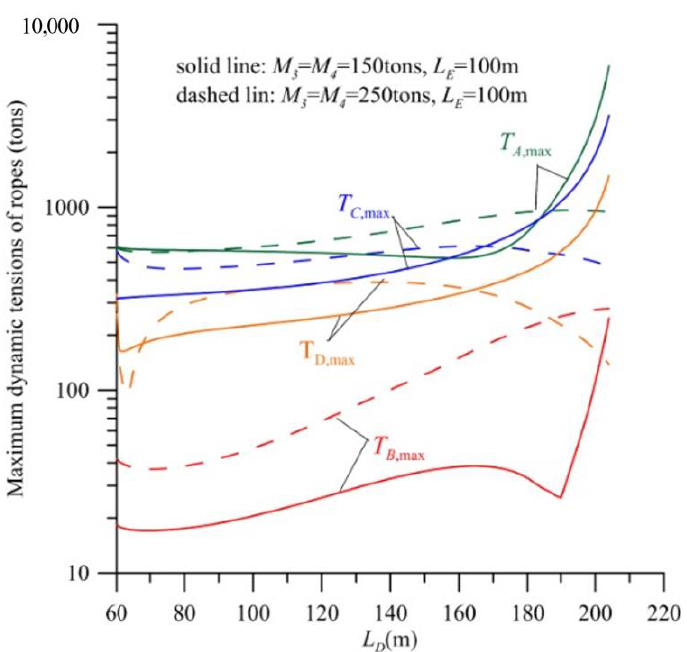
Figure 8. Dynamic tension of the four ropes under the typhoon irregular wave as a function of the diving length L D and the mass of pontoons M 3 and M 4 for L E = 100 m.